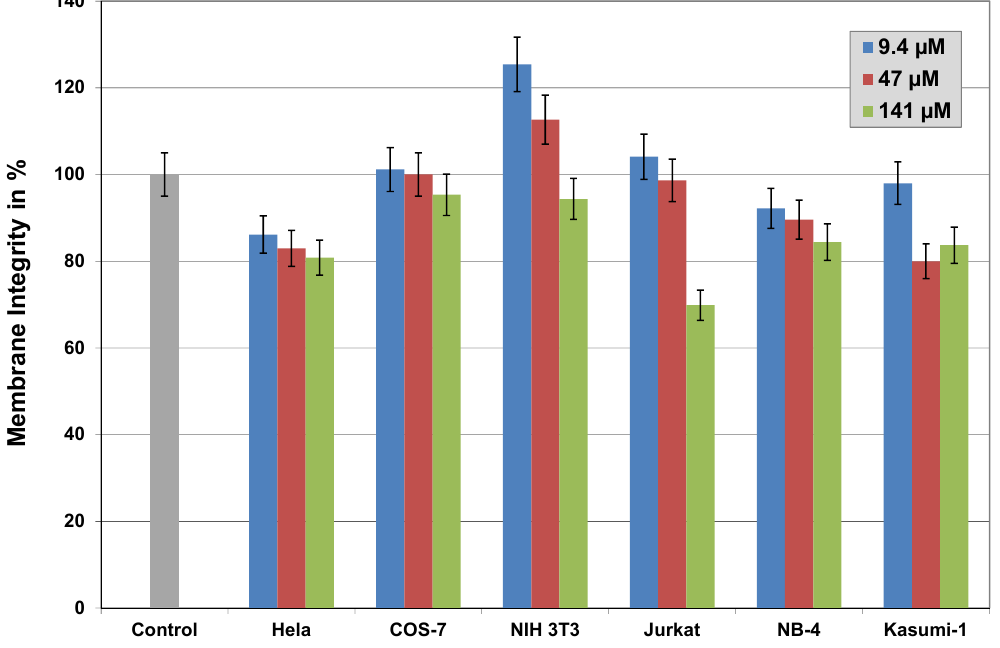
Figure 8. Influence of increasing concentrations of CAD-2 on membrane integrity of different cell lines. Membrane integrity was measured by the release of dead–cell protease using the CytoTox-Glo assay. HeLa and NB-4 cells are sensitive even to low concentrations (9.4 µM). 15-fold higher concentrations of CAD-2 enhance this effect only marginally. For other cell lines the initial value is reduced with increasing concentrations. However, the reduction of membrane integrity with increasing concentrations of CAD-2 up to 141 µM is very low.